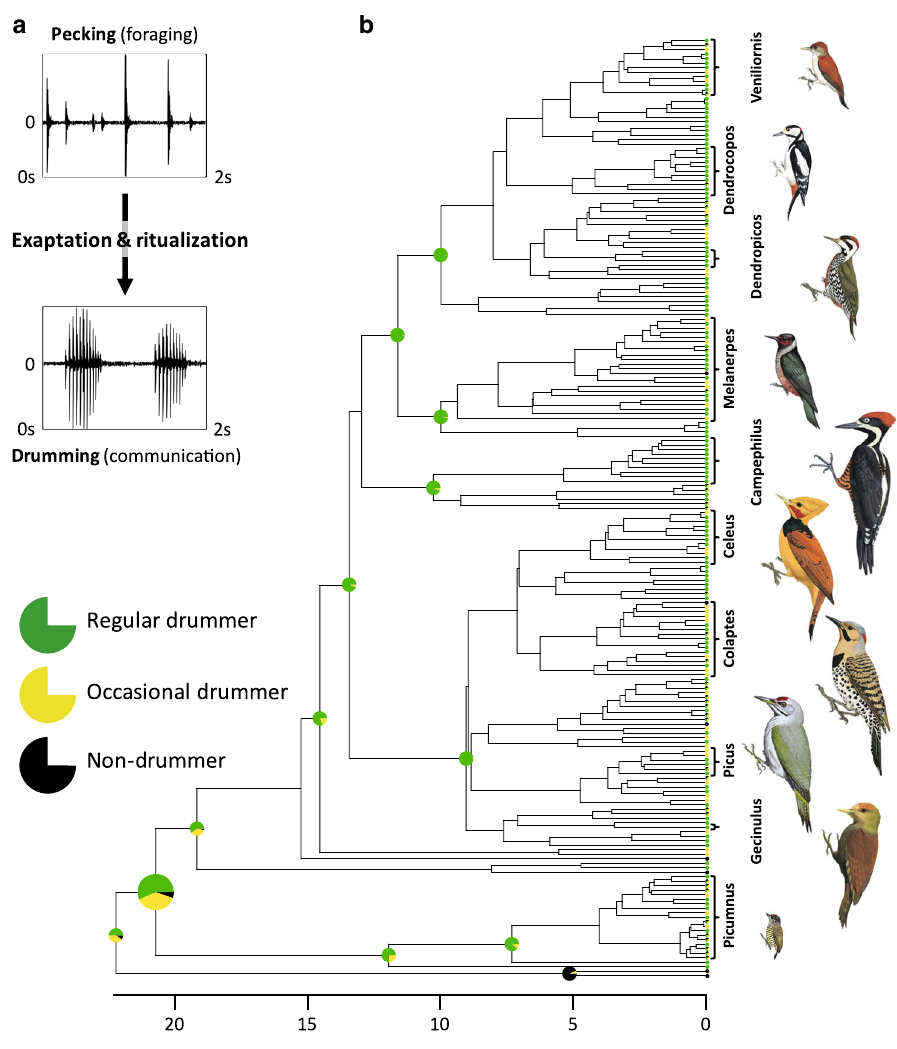
Fig. 1 Origin of drumming in woodpeckers. a Pecking, a foraging behaviour used in woodpeckers to excavate prey from tree trunk, has acquired a stereotypical and rhythmic structure, thus exapting into drumming, which holds a communicative function during mating and territorial defence. b Time- calibrated phylogenetic tree based on molecular data obtained by Bayesian inference. The tree shows the actual and the derived ancestral drumming behaviour in the woodpecker phylum. Pie charts are empirical Bayes posterior probabilities of ancestral states on internal nodes obtained from a continuous time Markov model (see ‘ Methods ’ ). For clarity, only selected pie charts are displayed at the nodes of large clades. Written genera (10 shown) indicate some of the groups included in subsequent analyses (total: genera: n = 22; species: n = 92; see Supplementary Data 1). Age is indicated in million years (Illustrations of woodpeckers reproduced by permission of Lynx Edicions). Source data are provided as a Source data fi